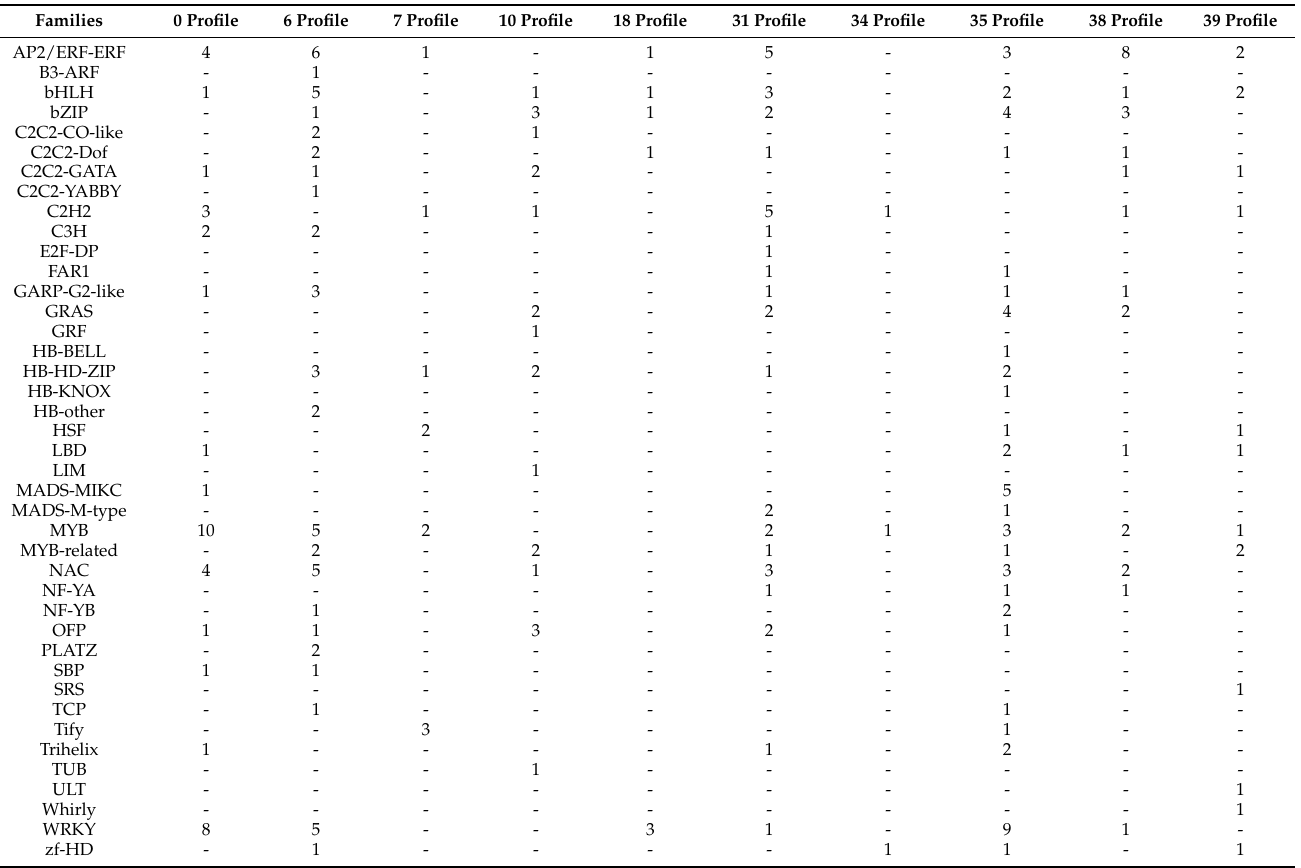
Table 1. Transcription factor families with distinct expression kinetics during age-dependent senes- cence identified via STEM